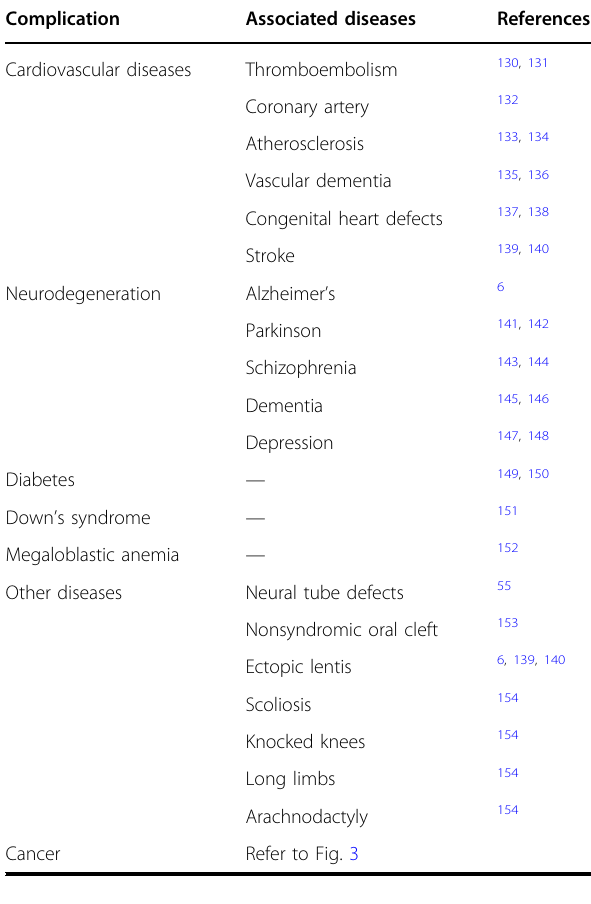
Table 1 Homocysteinemia and its associated disorders